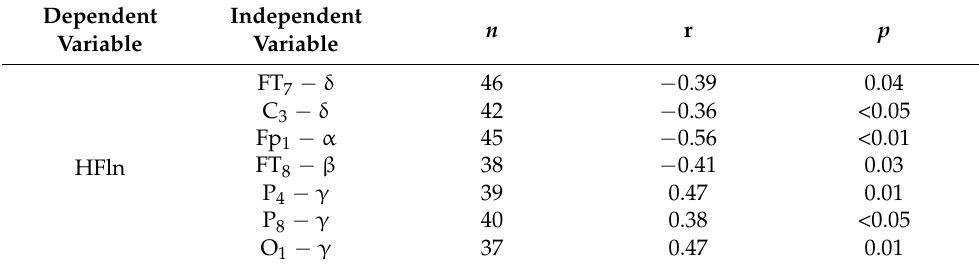
Table 5. Significant associations between electroencephalography variables and log transformed high frequency heart rate variability of train drivers.